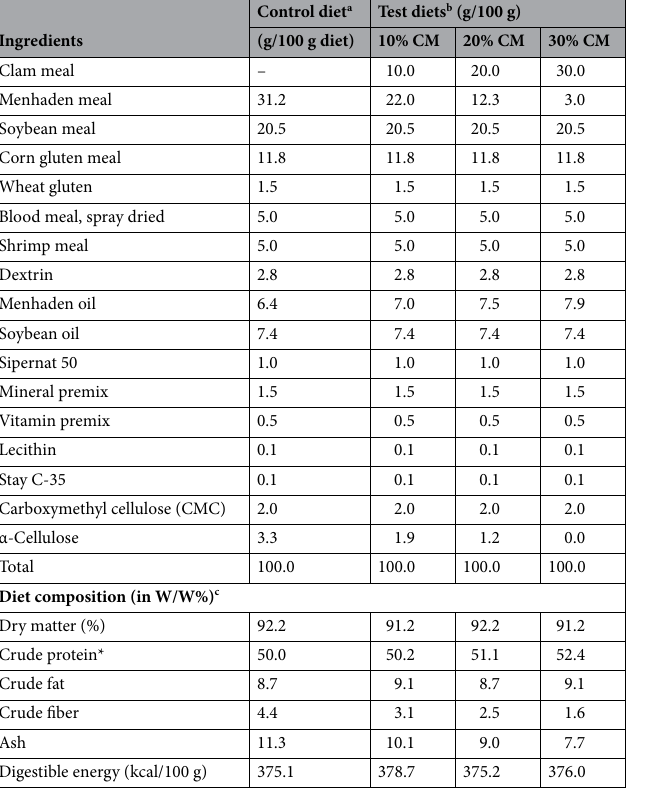
Table 1. Formulation and analyzed composition of the experimental diets. a Riche & Williams. Aquaculture Nutrition, 2011, 17: 368–379, with some modification. b Test diets are formulated to have 10%, 20% and 30% CM (clam meal) of the diet while replacing FM. They are isonitrogenous and iso-lipidic with the control diet. c Analyzed by the Experiment Station Chemical Laboratories (ESCL), University of Missouri, Columbia, MO 65211. Results are expressed on an “as is” basis unless otherwise indicated. W/W% = grams per 100 g of sample. Crude protein* = %N ×